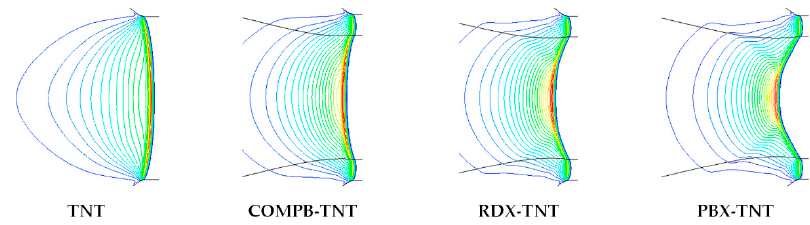
Figure 3. Stable propagation forms of detonation waves in OSC and DLSC.